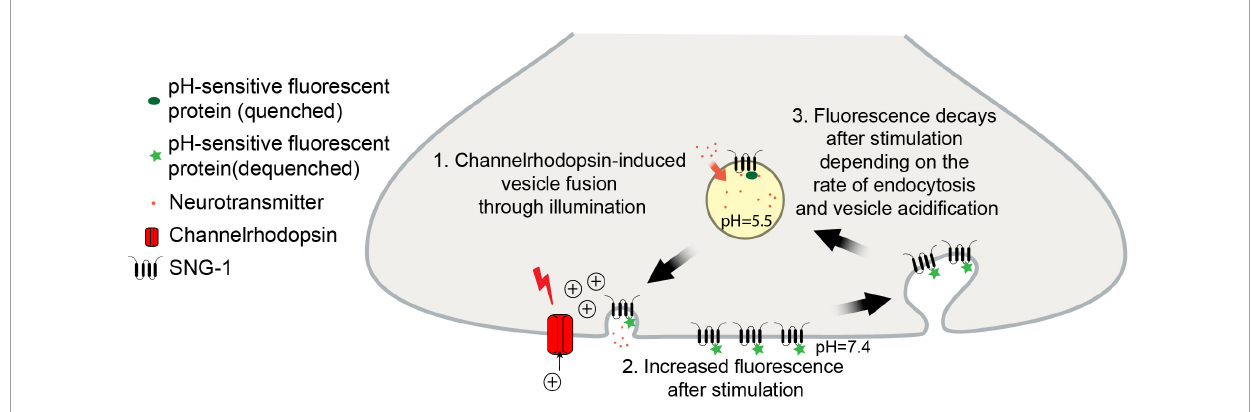
FIGURE1 Schematic of the pOpsicle assay. pH-sensitive fluorescent proteins fused to SNG-1 are exposed to the neutral extracellular medium in response to optogenetic stimulation which leads to an increase in fluorescence.